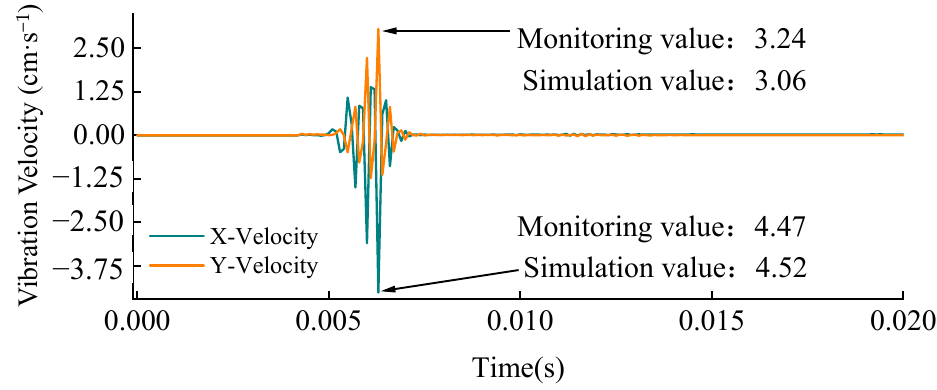
Figure 3. The change of blasting vibration duration at the top of the slope. In this section, vertical and horizontal vibration velocities were selected for analysis. The effect of heights on blast vibration velocity within the same slope was analyzed, and the inference obtained by fitting Equation (2) and fitting Equation (3) was verified to be consistent with the numerical simulation results. In the slope model, feature points have the same horizontal distance ( D ) and various height differences ( H ) as the data from working condition I. The feature points were named C 1 –C 6 from bottom to top, as shown in Figure 4.